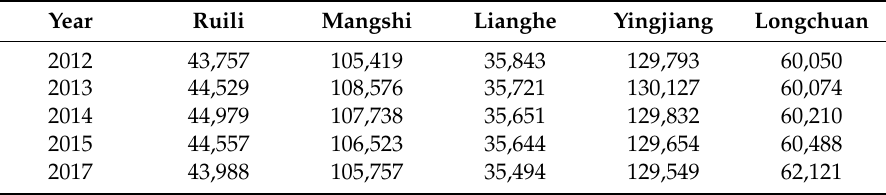
Table 3. Total digital number (DN) values for the DH Prefecture from 2012 to 2017.